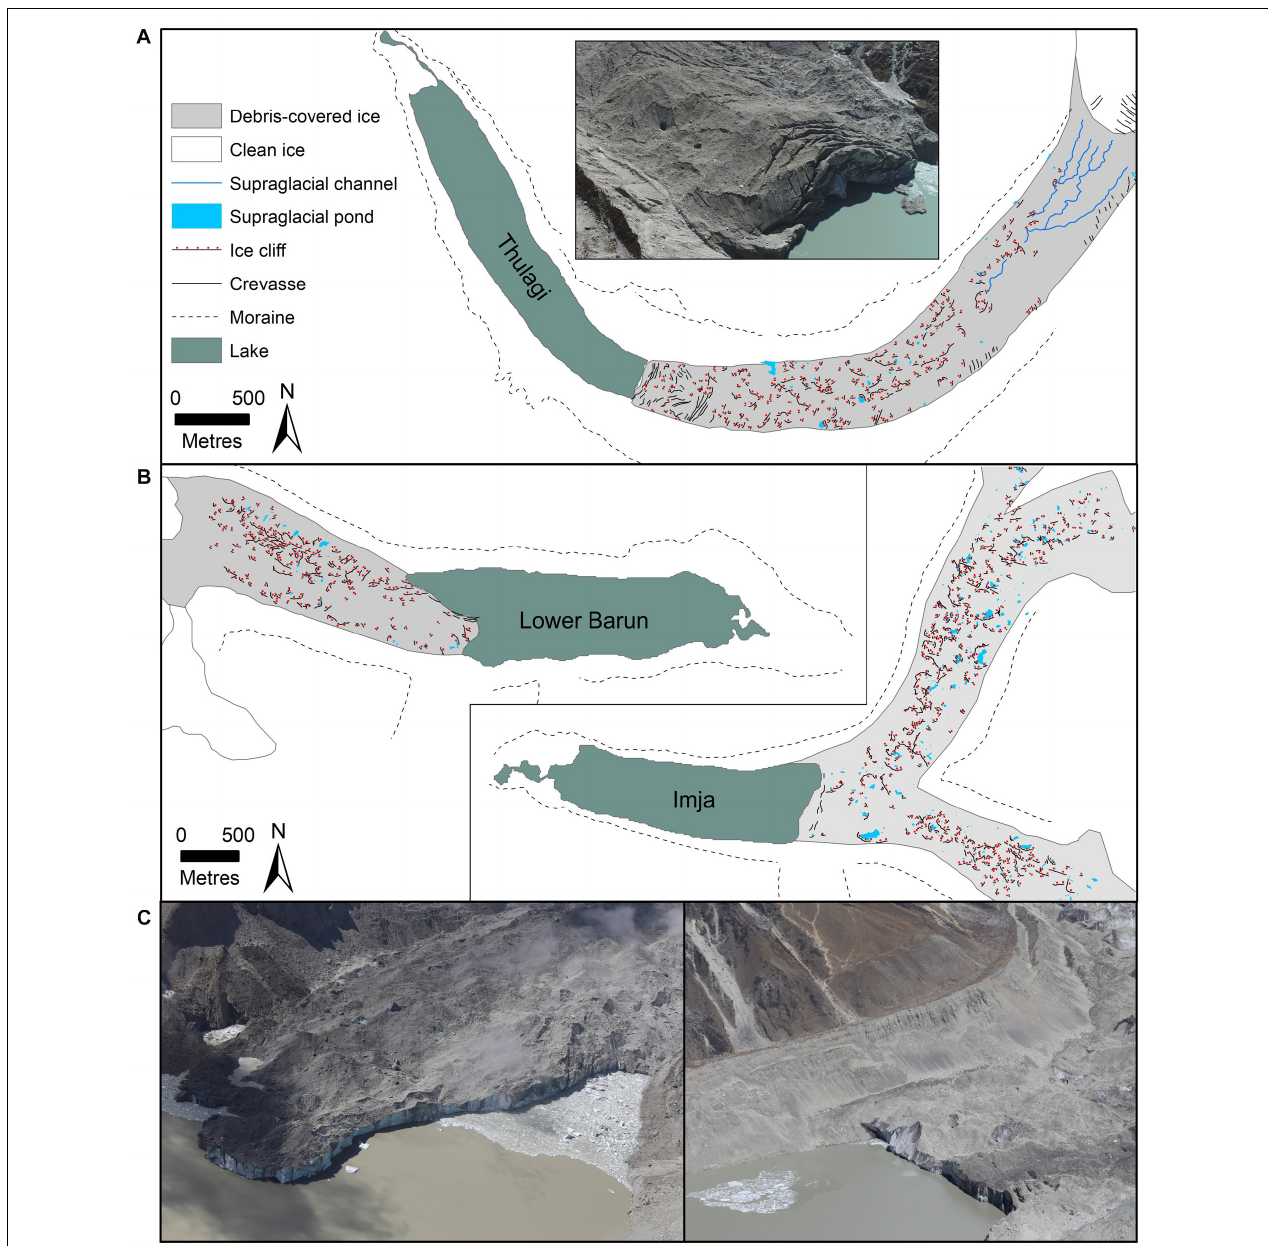
FIGURE 5 | Surface morphology of (A) Thulagi Glacier (inset is a terminus photo from October 2017) and (B) Lower Barun and Lhotse Shar/Imja glaciers. (C) Aerial photographs of the calving fronts of Lower Barun (left) and Lhotse Shar Glacier (right) taken October 2015.